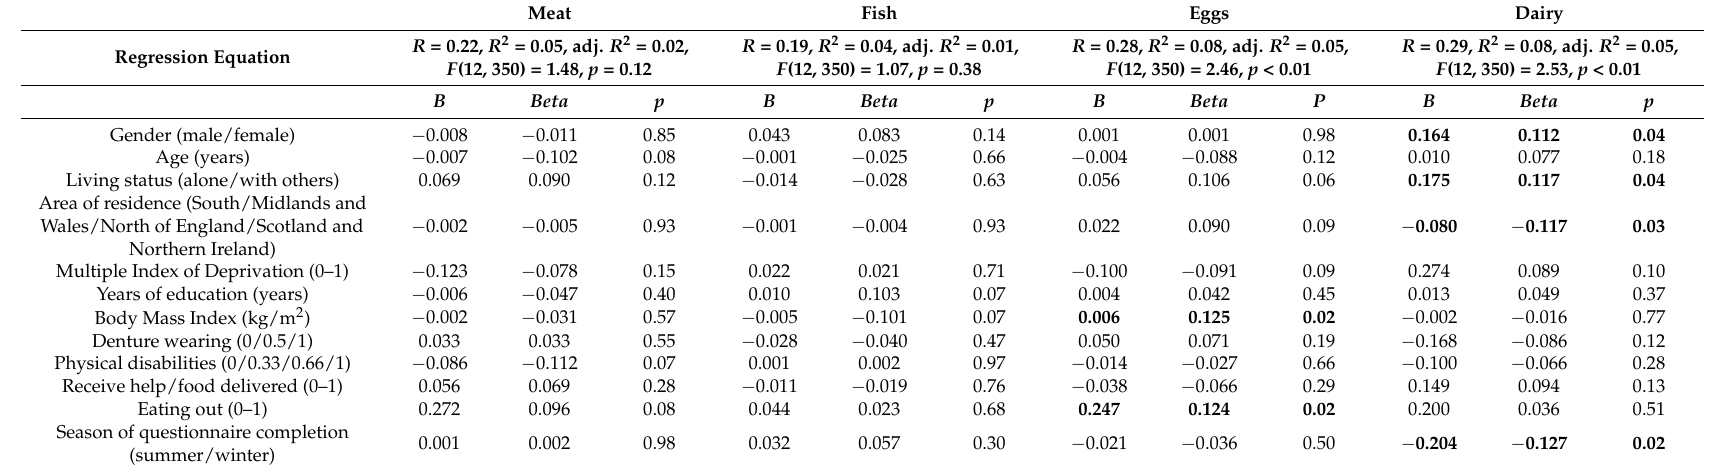
Table 1. Outcomes of the regression analyses investigating the impact of demographic and lifestyle characteristics for each food group studied. Meat Fish Eggs Dairy R = 0.22, R 2 = 0.05, adj. R 2 = 0.02, Regression Equation F (12, 350) = 1.48, p =